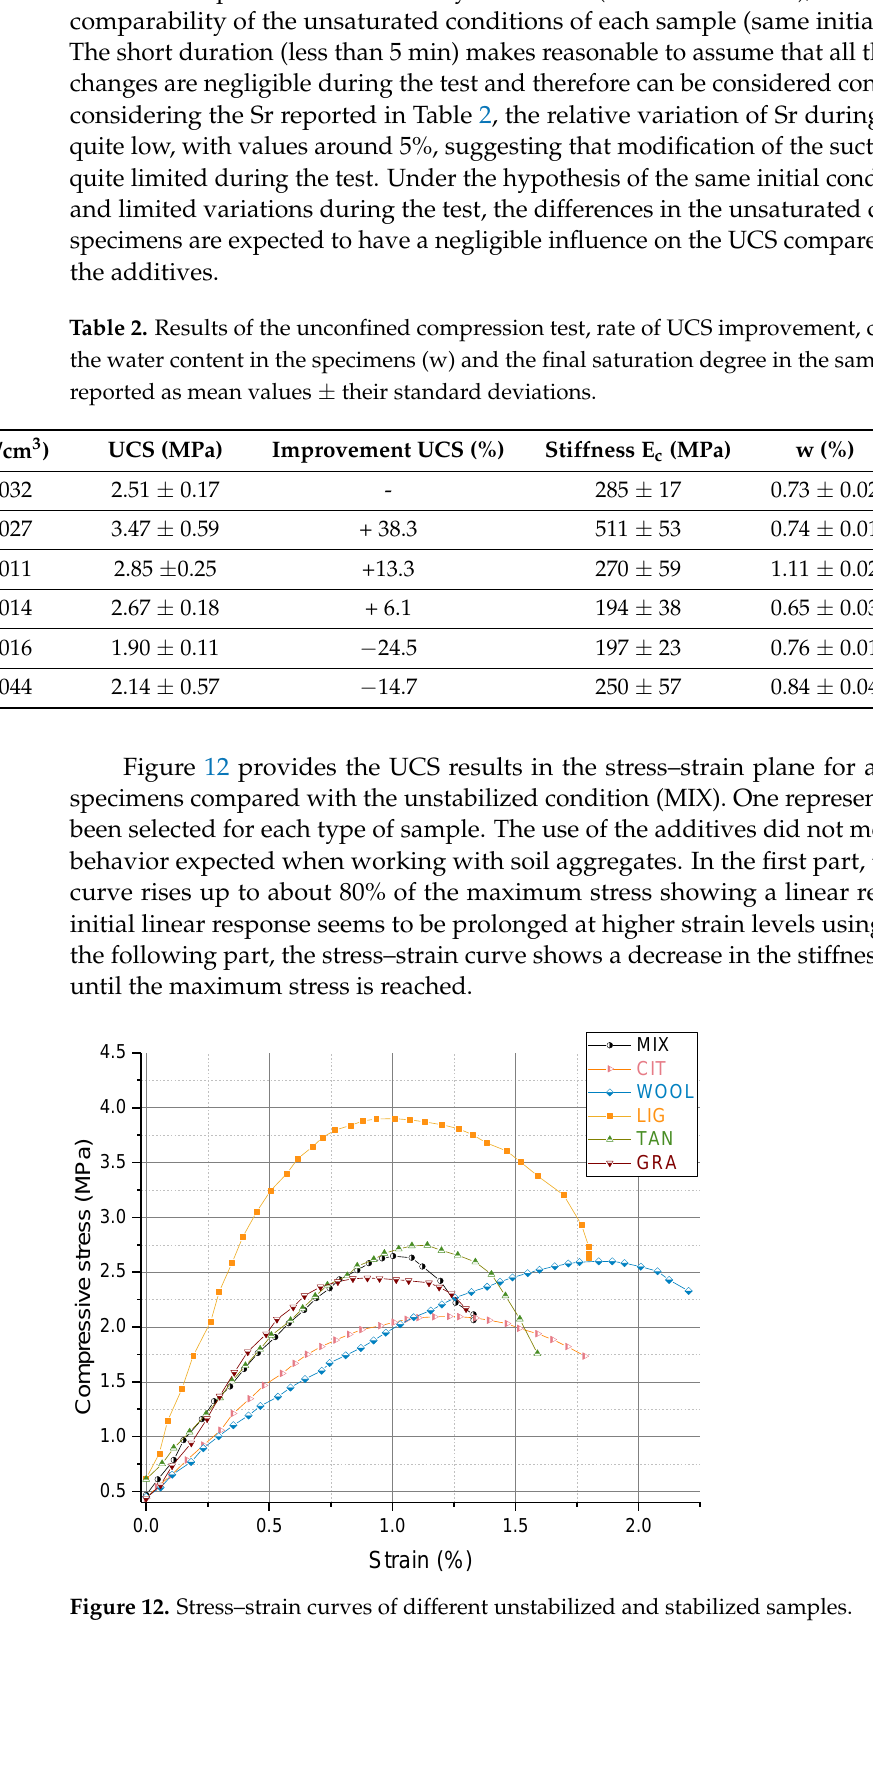
Figure 12. Stress–strain curves of different unstabilized and stabilized samples. Considering the stiffness, the slope of the linear part was calculated as the slope (E c ) of the chord between 0.5 MPa and the 80% of the maximum load of the stress–strain curve, which identifies the linear behavior of the curve and represents a reasonable estimation of the stiffness of the material. The result given is the average of the E c of the three samples. This method is an adaptation of the one proposed for concrete by Neville [69]. This technique is similar to the method suggested by Rodríguez-Mariscal et al. [70] for unfired earthen material, which considers the chord modulus as the slope of the secant line passing by one-third and two-thirds of the maximum load since the stress–strain curve shows a linear trend within this range [70]. The test was conducted on samples in equilibrium with the same temperature and humidity conditions (20 °C and 59.14%), in order to assure the comparability of the unsaturated conditions of each sample (same initial suction for all). The short duration (less than 5 min) makes reasonable to assume that all the water content changes are negligible during the test and therefore can be considered constant. Moreover, considering the Sr reported in Table 2, the relative variation of Sr during the UCS test is quite low, with values around 5%, suggesting that modification of the suction conditions is quite limited during the test. Under the hypothesis of the same initial conditions of suction and limited variations during the test, the differences in the unsaturated conditions of the specimens are expected to have a negligible influence on the UCS compared to the effect of the additives. Figure 12 provides the UCS results in the stress–strain plane for all the stabilized specimens compared with the unstabilized condition (MIX). One representative curve has been selected for each type of sample. The use of the additives did not modify the typical behavior expected when working with soil aggregates. In the first part, the stress–strain curve rises up to about 80% of the maximum stress showing a linear relationship. The initial linear response seems to be prolonged at higher strain levels using wool fibers. In the following part, the stress–strain curve shows a decrease in the stiffness of the samples until the maximum stress is reached. Figure 13 reports the results of UCS and E c for the different specimens, comparing the average value with the minimum and maximum value recorded and the standard deviation. The unstabilized specimens of MIX showed UCS values around 2.5 MPa, while the UCS was reduced by about 25% when using citrus pomace and grape-seed flour. The